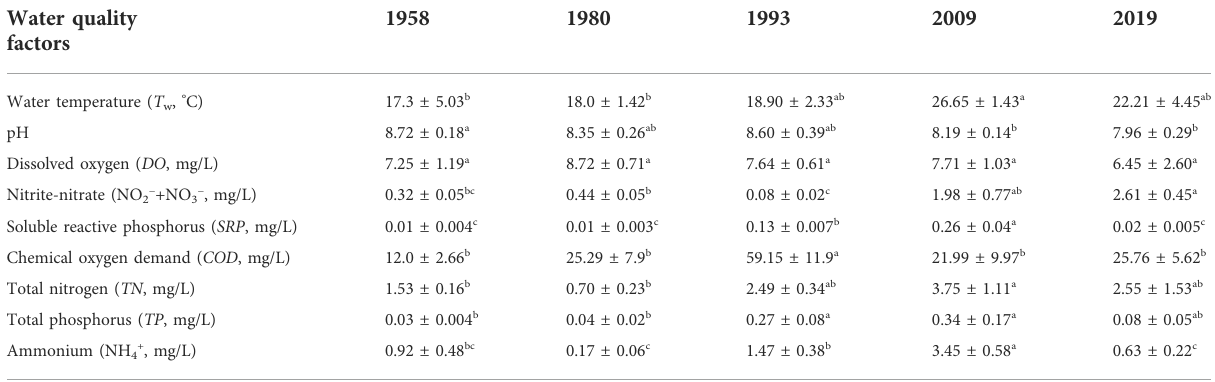
TABLE 3 Mean and standard deviation (mean ± SD) for the water quality variables in the fi ve study years. Values of a variable followed by different letters(a,b,c)differedsigni fi cantlybetweenstudyyears(one-wayANOVAfollowedby LSD testorKruskal – WallistestfollowedbyMann-Whitney U test, p < 0.05).